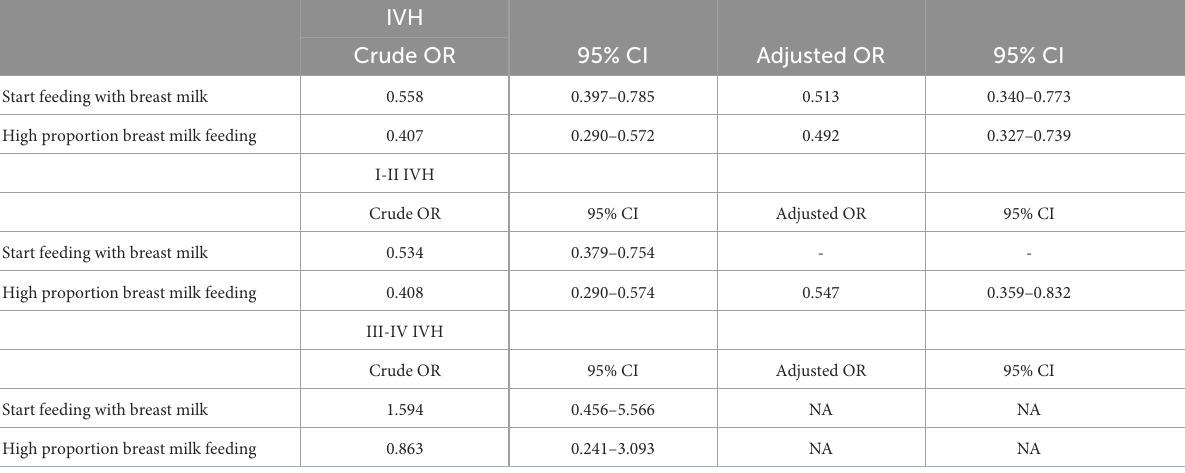
TABLE 4 Analysis of the association of high-proportion breast milk feeding and start breast milk feeding with IVH (include IVH, I-II IVH, III-IV IVH) risk in